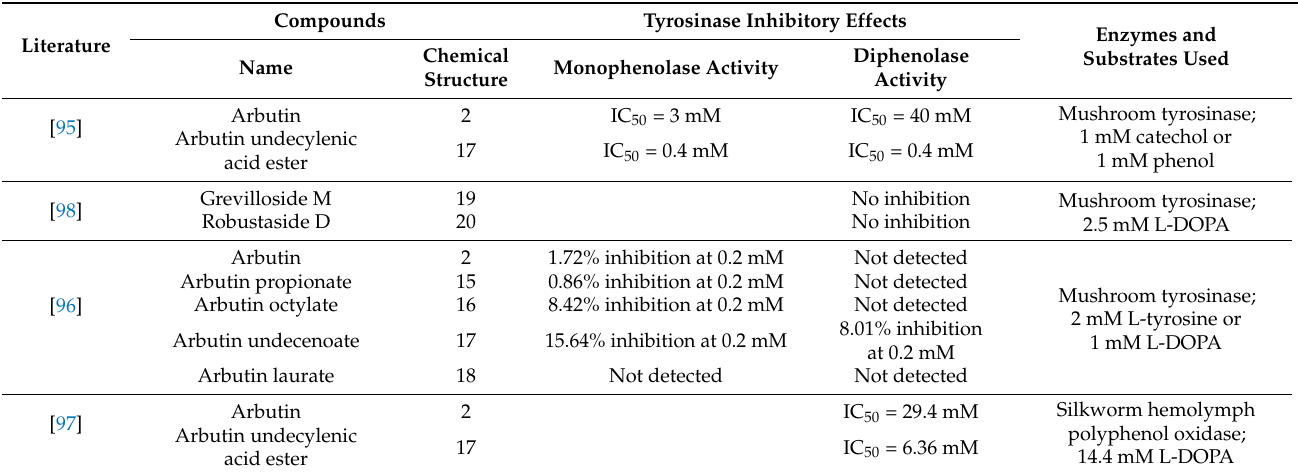
Table 3. Tyrosinase inhibitory effects of various esters of arbutin.